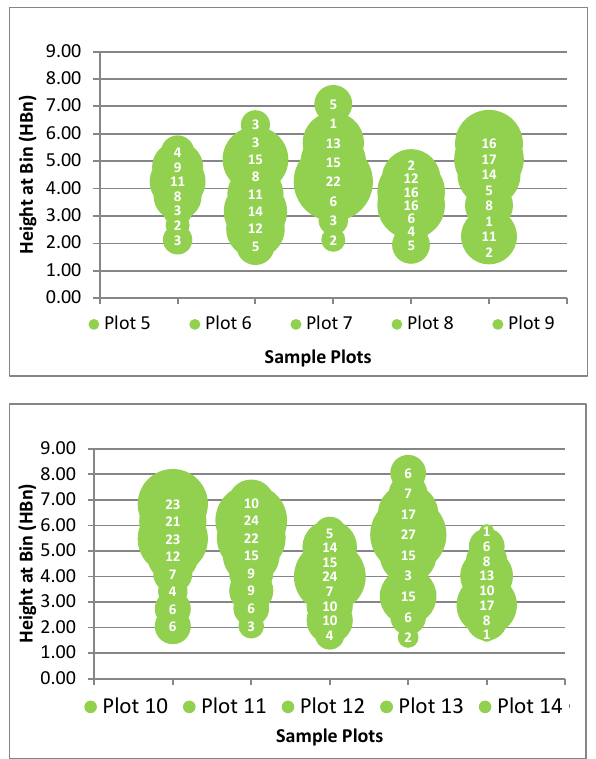
Figure 6. Visualization of the point density distribution clustering for sample plots located at the periphery of the forest 3.4 Canopy Cover Characteristics The canopy cover derived from LiDAR was also examined to further enhance the characterization study. The number of trees per plot, as well as the average Diameter at Breast Height (DBH) that was collected in-situ were correlated to the Canopy Cover values. The overall canopy cover of the sample plots located at the middle parts of the forest have Medium (80- 94.99) to High (95-100) canopy cover, while plots that are located along the peripheries have values ranging from Low Figure 5. Visualization of the point density distribution (below 80) to High (95-100) as shown in Table 4. clustering for sample plots located at the middle part of the forest The correlation between LiDAR canopy cover and Field DBH suggest that there is a direct relationship between the two as shown in Figure 7 and 8, respectively. However, it was also observed that the individual tree species situated in each sample plot greatly influence the correlation. The different cases and the corresponding correlation is shown in Table